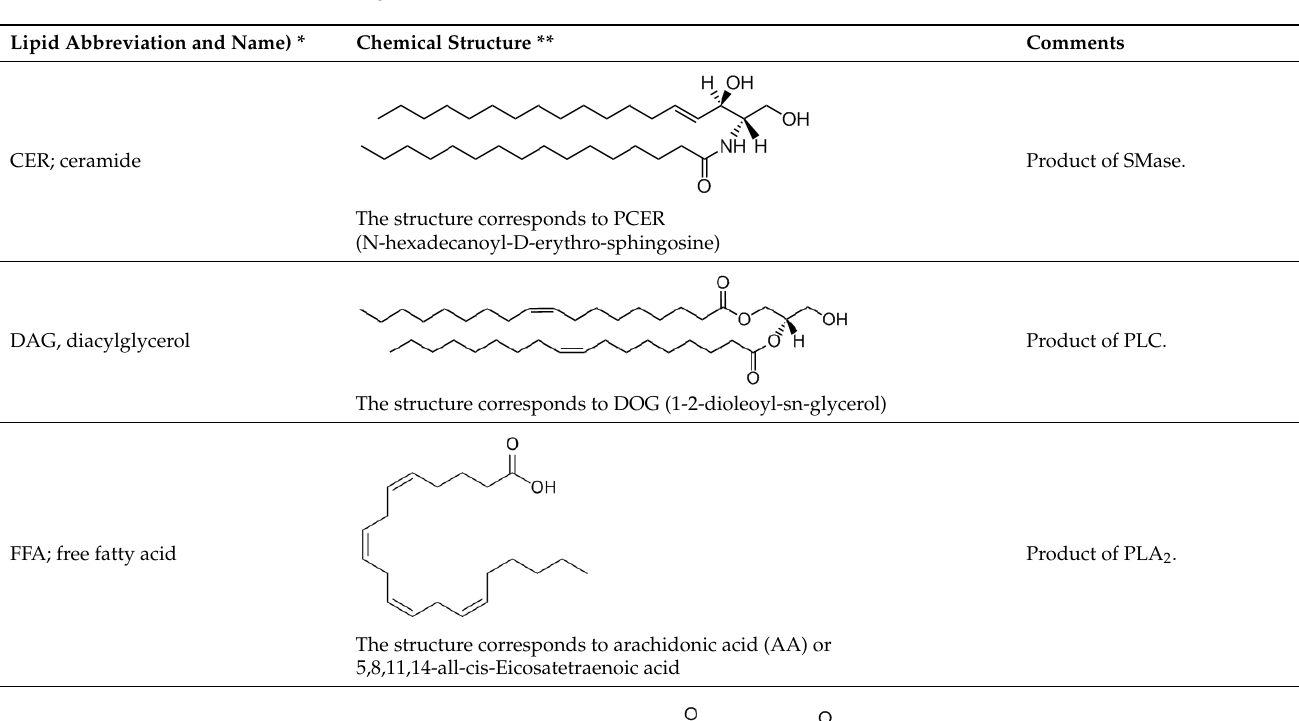
Table 1. Abbreviations in alphabetic order, names and chemical structures of the lipids are commented on in this work. Additionally, information on their relationship with the phospholipases commented on is given.